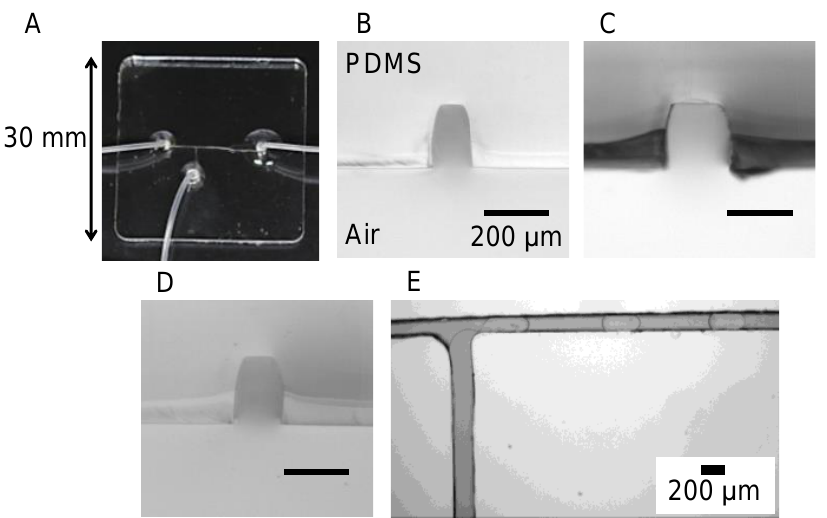
Figure 3. ( A ) A picture of a microfluidic device. ( B – D ) Microscopic images of cross section of recessed microchannel patterns on PDMS substrate. Images were taken at ( B ) left part, ( C ) bottom part, and ( D ) right part of the T-junction. Scale bars: 200 µ m. ( E ) A microscopic image of plug flow in a T-shaped microchannel. Dispersed phase: PBS (1 µ L min − 1 ). Continuous phase: Oil for droplet digital PCR (4 µ L min − 1 ).